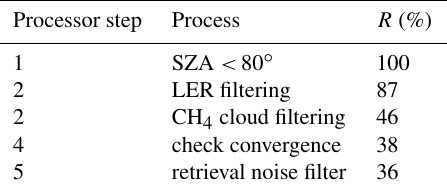
Table 2. Fraction of data to be processed during the successive processor steps for the TROPOMI test orbit ensemble relative to the 572442 spectra of the orbit ensemble that are filtered for SZA < 80 ◦